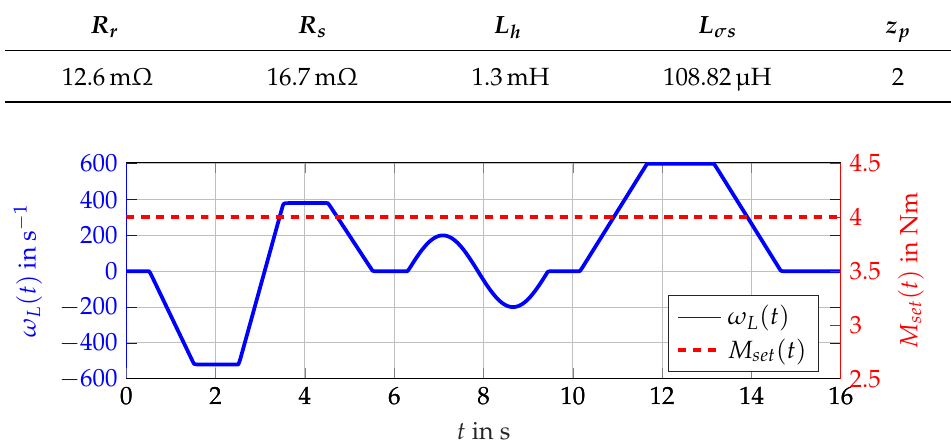
Table 1. Parameters of the induction machine under consideration.